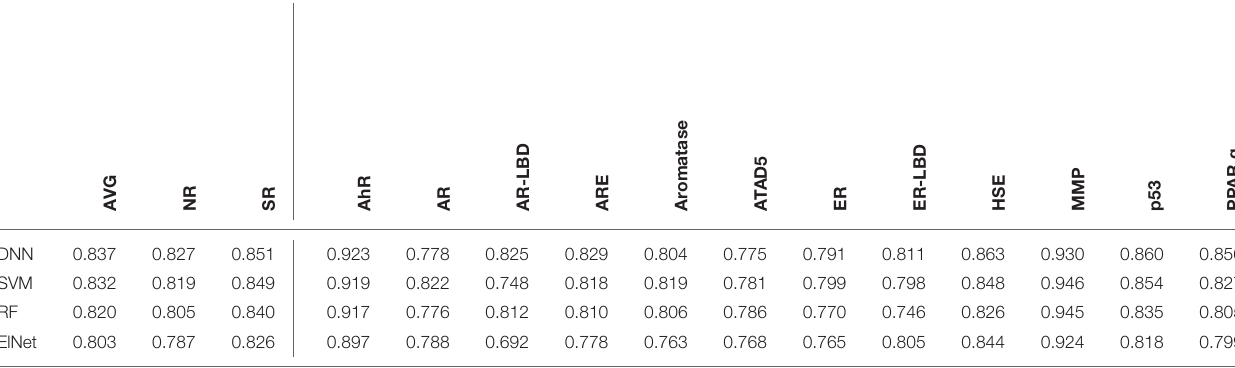
TABLE 4 | AUC Results for different learning methods as part of DeepTox evaluated on the final test set.